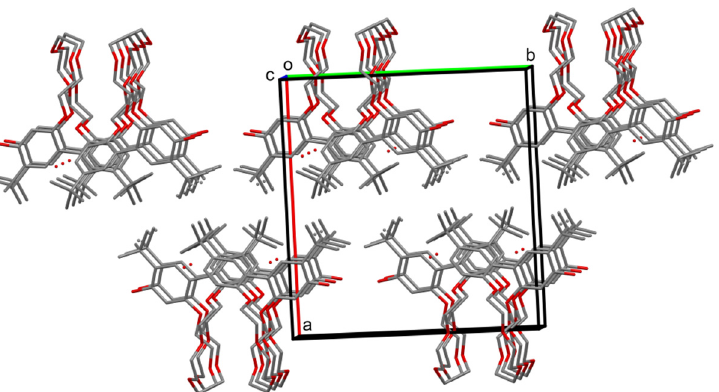
Figure 11. Crystal packing of t -Bu-17- p -OH . The molecules with folded ether linker are gathered into chains in (001) direction and then into layers parallel to (100) planes. The next layer fills the gaps between the ether linkers in the c axis direction with its etheric parts (omitted for clarity); this is equivalent to a parallel shifting, upwards of the bottom layer in the picture. This process forms hydrophobic and hydrophilic regions, like those in t -Bu-19- o -OH . Hydrogen atoms are